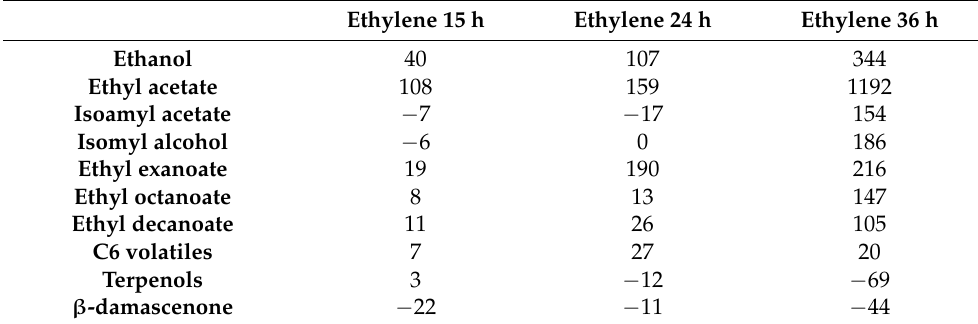
Figure 2. Principal component analysis (PCA) score plot ( A , top) and loading plot ( B , bottom) including graphical representations of PC1 vs. PC2. Scores included in the plot ( A ) are not scaled on loading values. Table 3. Percentage of increase or decrease (–) of main selected volatile organic compounds (VOCs) in ethylene-(15, 24, and 36 h)-treated samples over air-treated sample at the end of 36 h treatment. C6 compounds include hexanol, hexanal, and (E)-hex-2-enal. Reported values are calculated on original data which, in turn, were derived from the mean of three gas chromatography (GC) runs, each one made with grape juice obtained from three different